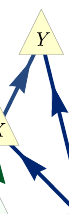
Figure 12: The instrumental scenario of Pearl